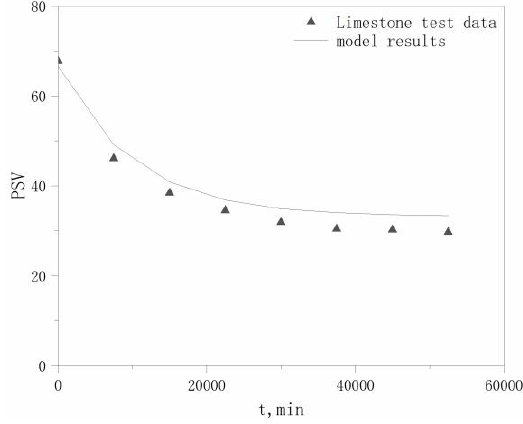
Fig. 4 Modeled and tested PSV Results for calcined bauxite. Fig. 5 Modeled and tested PSV results for granite. Fig. 6 Modeled and tested PSV results for basalt.